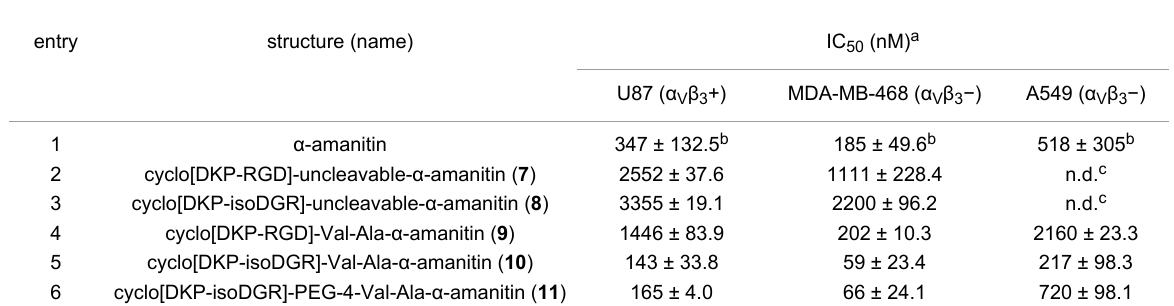
Table 3: Evaluation of anti-proliferative activity of α -amanitin and α -amanitin conjugates 7 – 11 in U-87, MDA-MB-468 and A549.